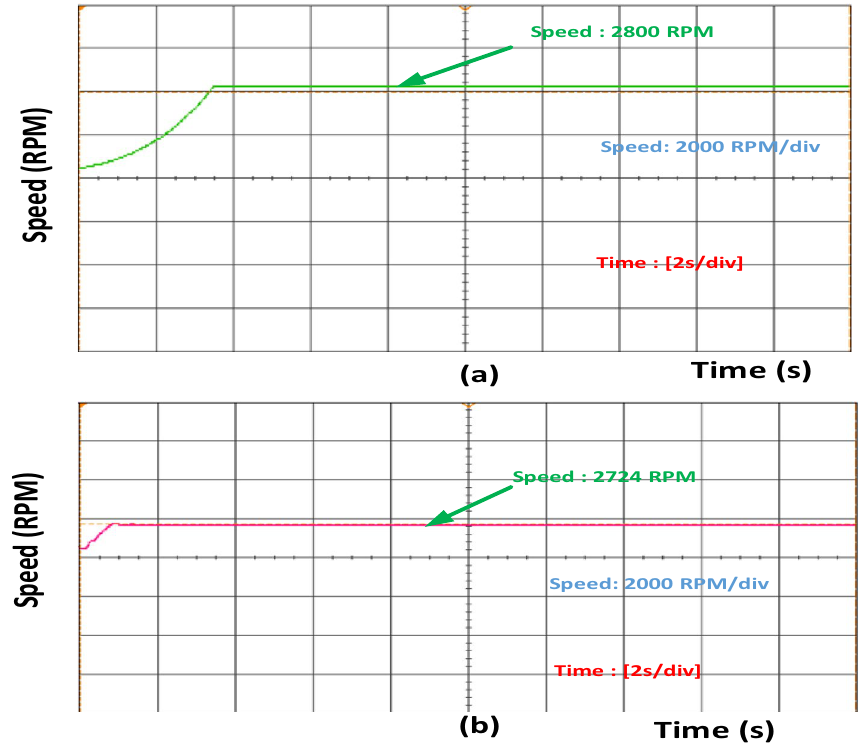
Figure 4. ( a ) Speed for induction motor in healthy condition. ( b ) Speed for induction motor 40% stator inter turn fault occurs.